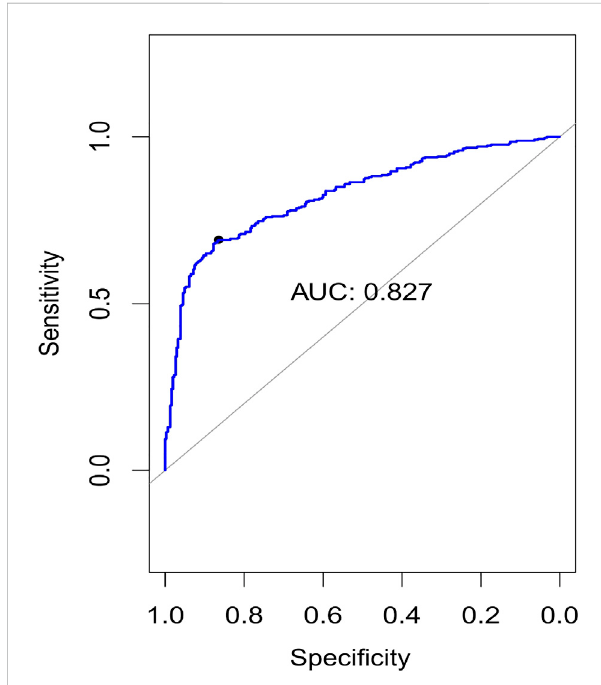
FIGURE 4 Plots of the area under curve (AUC) for 10-fold cross-validation.